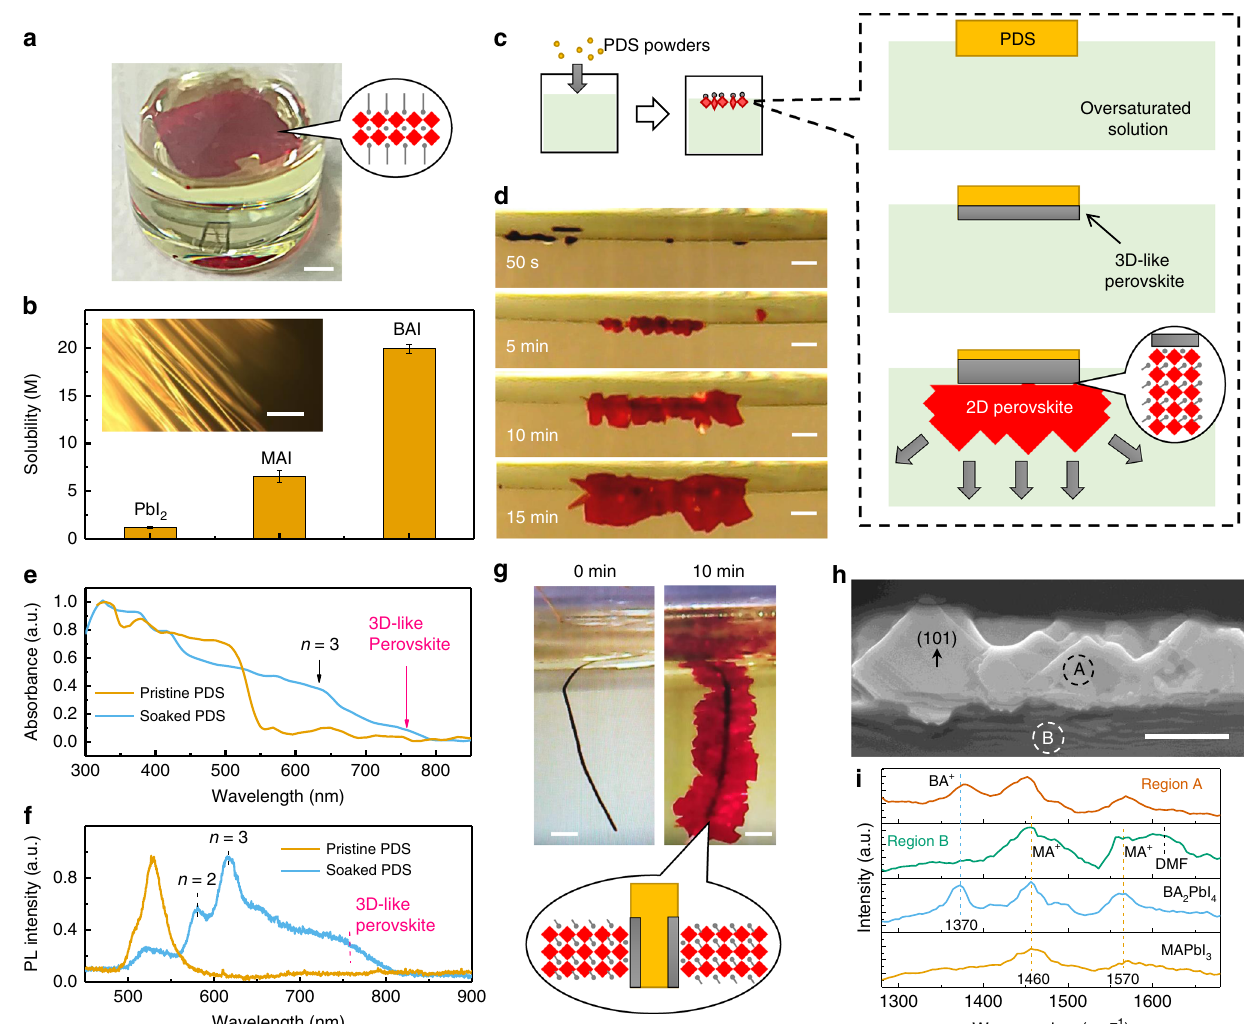
Fig. 2 Templated growth of layered perovskites on 3D-like perovskites. a BA 2 MAPb 2 I 7 single crystal formed on the air/liquid interface by slowly cooling supersaturated solution. The scale bar is 2 mm. b Comparison of the solubility of PbI 2 , MAI, and BAI in DMF solvent, where the insets shows the fi rst precipitation of PbI 2 -DMF-contained solvate phases (PDS) in BA-based RP perovskite precursor solution during drying. The error bars represent the s.d. of three measurements. The inset scale bar is 10 μ m; c , d illustration ( c ) and optical photos ( d ) of the directional growth of BA-based RP perovskite crystals under the intentionally spread PbI 2 -DMF powder at the liquid surface of the oversaturated precursor solution (< n > = 2). The scale bar is 0.5 mm. The right panel illustrates the formation of 3D-like perovskites on soaked PDS surface, which triggers directional growth of RP perovskites; e , f optical absorption spectrum ( e ) and PL spectrum ( f ) of soaked PbI 2 -DMF with 3D-like perovskites formed on surface; g optical photos of the directional growth of BA-based RP crystals on PbI 2 -DMF fi bers soaked in the oversaturated precursor solution ( <n> = 2). The scale bar is 0.5 mm. h SEM image of RP perovskite grow from 3D-like perovskites coated PDS. The scale bar is 10 μ m; i localized infrared spectra of the RP perovskites and 3D-like perovskites coated PDS (e.g., the region A and region B marked in ( h ), respectively) as measured by